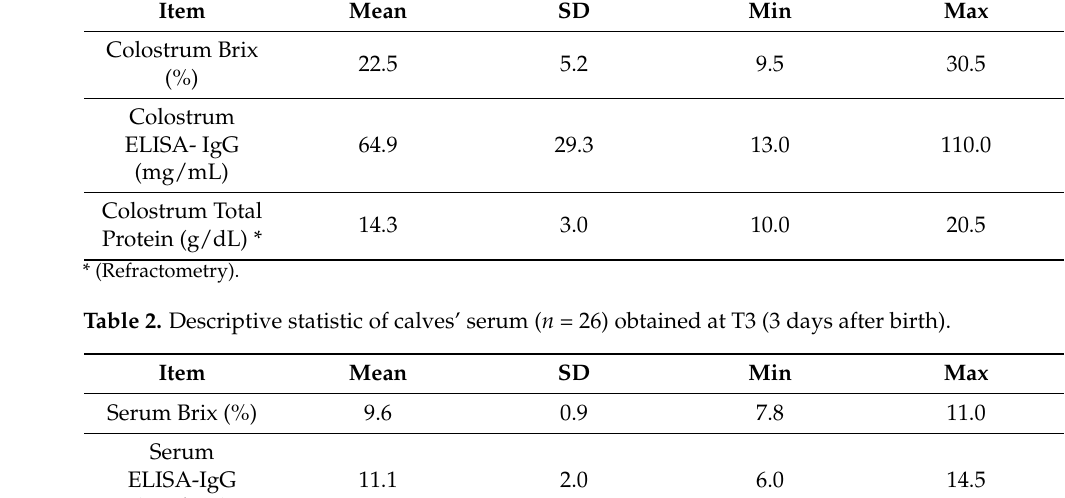
Table 1. Descriptive statistic of maternal colostrum (MC) from first-calf heifers ( n = 26). Item